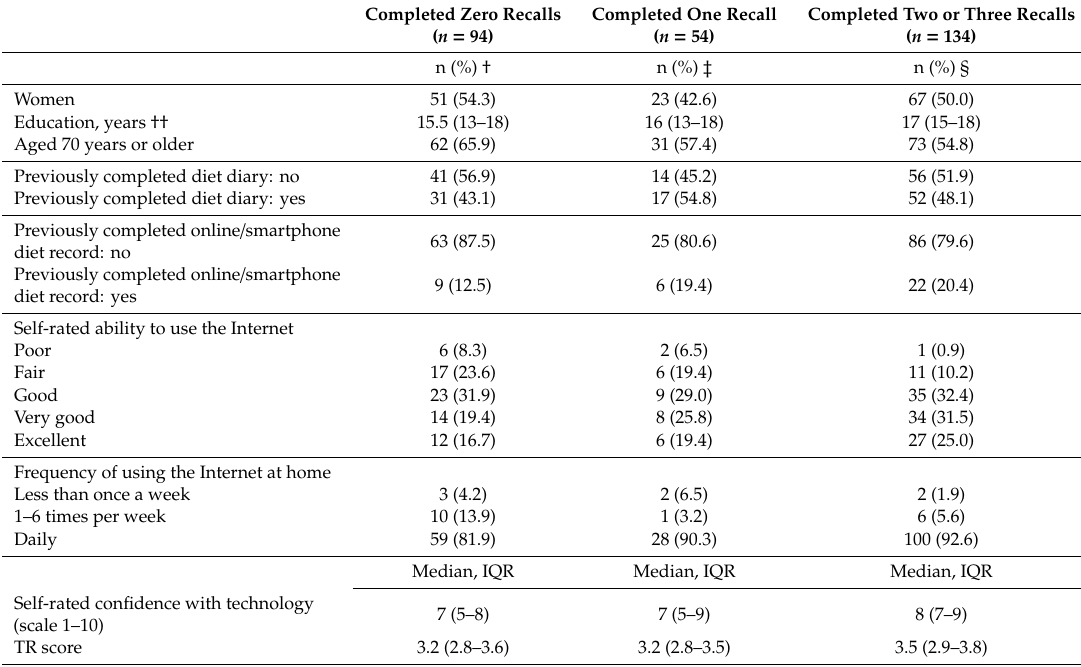
Table 2. Completion of zero vs. one or more myfood24 recalls: comparison of demographic and technology readiness characteristics.